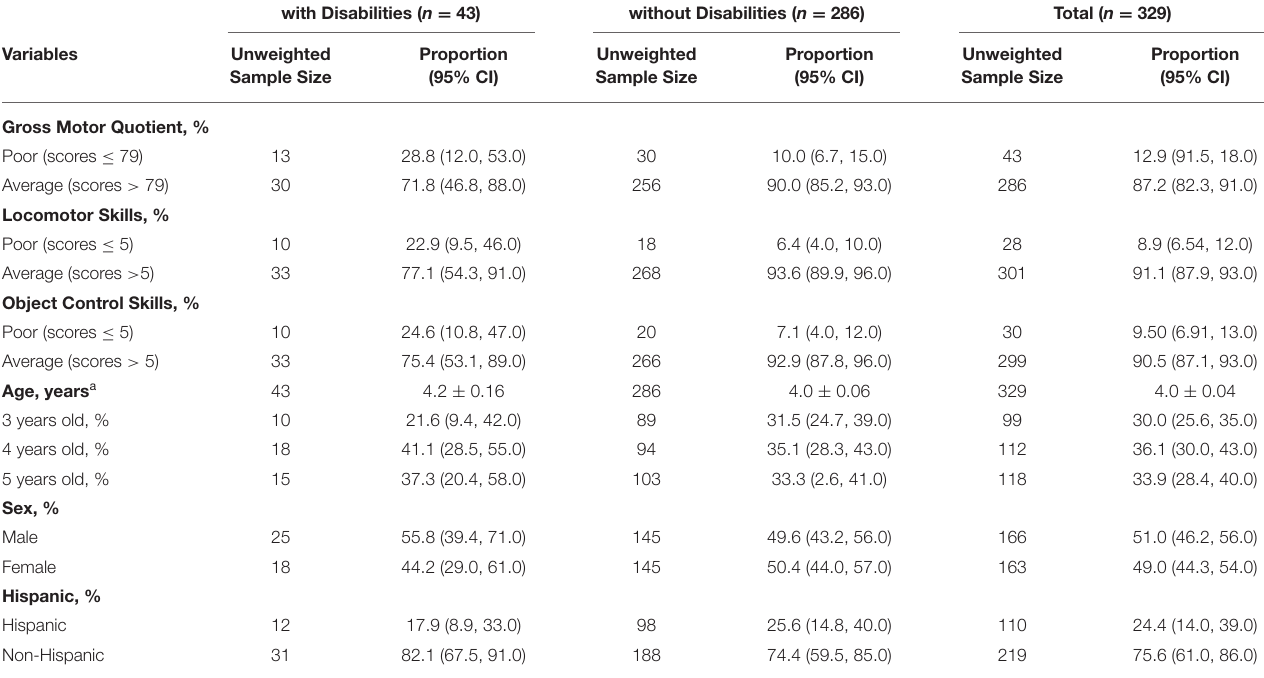
TABLE 1 | Demographic characteristics of children with and without disabilities participating in the 2012 NYFS.